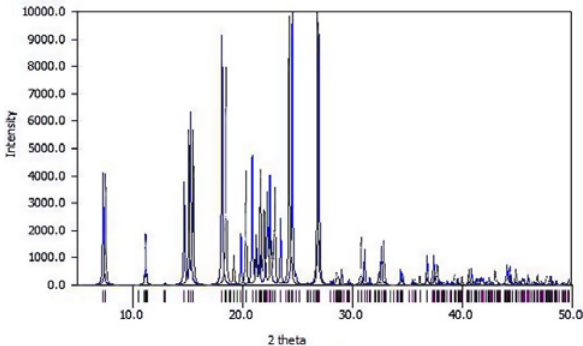
Fig. 7. Comparison of the XRD spectrum of Str 302 (black) and Form I (benz2) (blue)